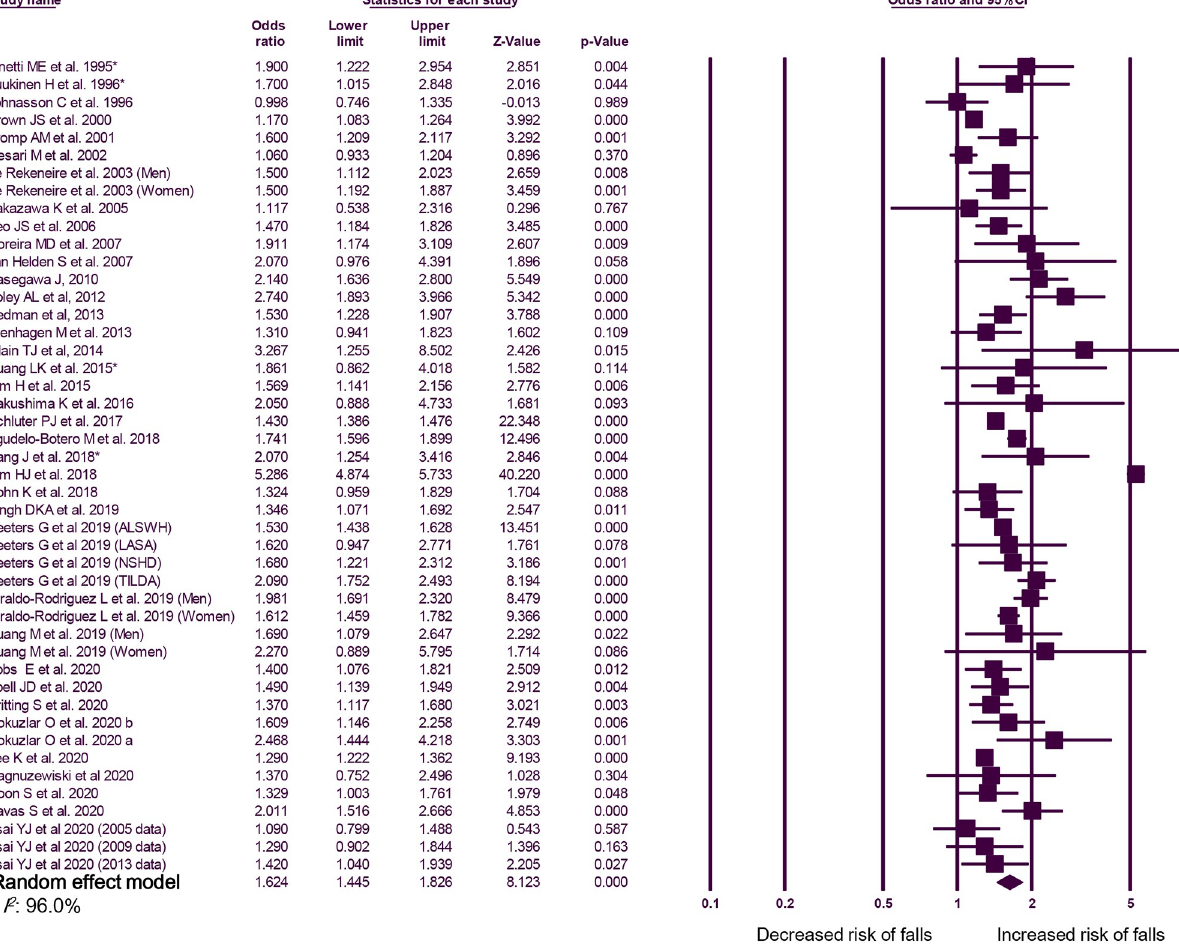
Fig 3. Forest plots of the risk ratio of the association between urinary incontinence and falls. OR, odds ratio; CI, confidence interval. � Study that defined falls as at least two falls within 1